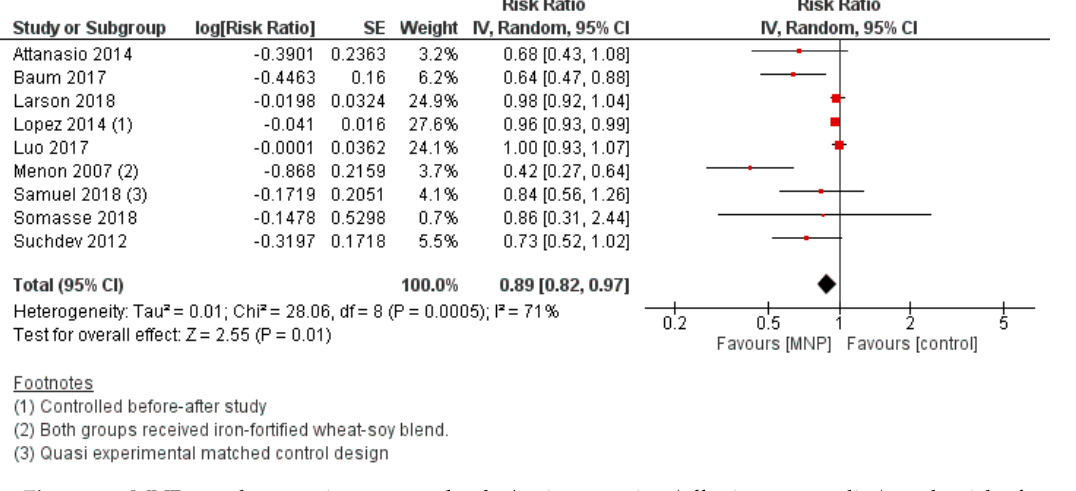
Figure 10. MNP supplementation versus placebo/no intervention (effectiveness studies) on the risk of anemia (hemoglobin concentration < 110 g/L).